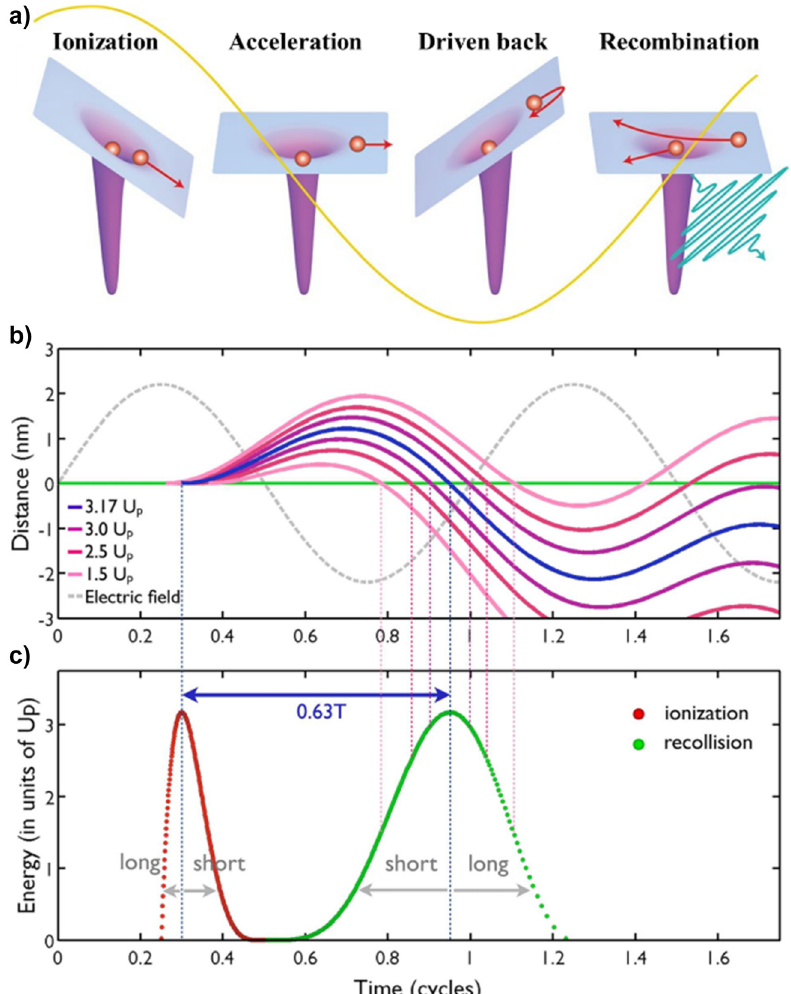
Figure 7: Three-step model and strong field approximation of HHG. (a) An illustration of the three-step model